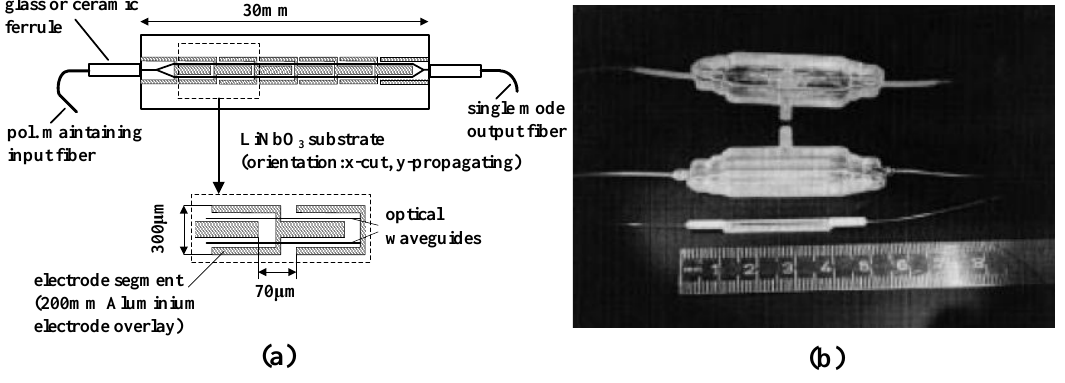
Figure 6. ( a ) Segmented electrodes proposed to improve the sensitivity and bandwidth [59]; ( b ) The sensor sealed with epoxy resin [62] (Copyright © 1997 IEEE, Reprinted with permission).